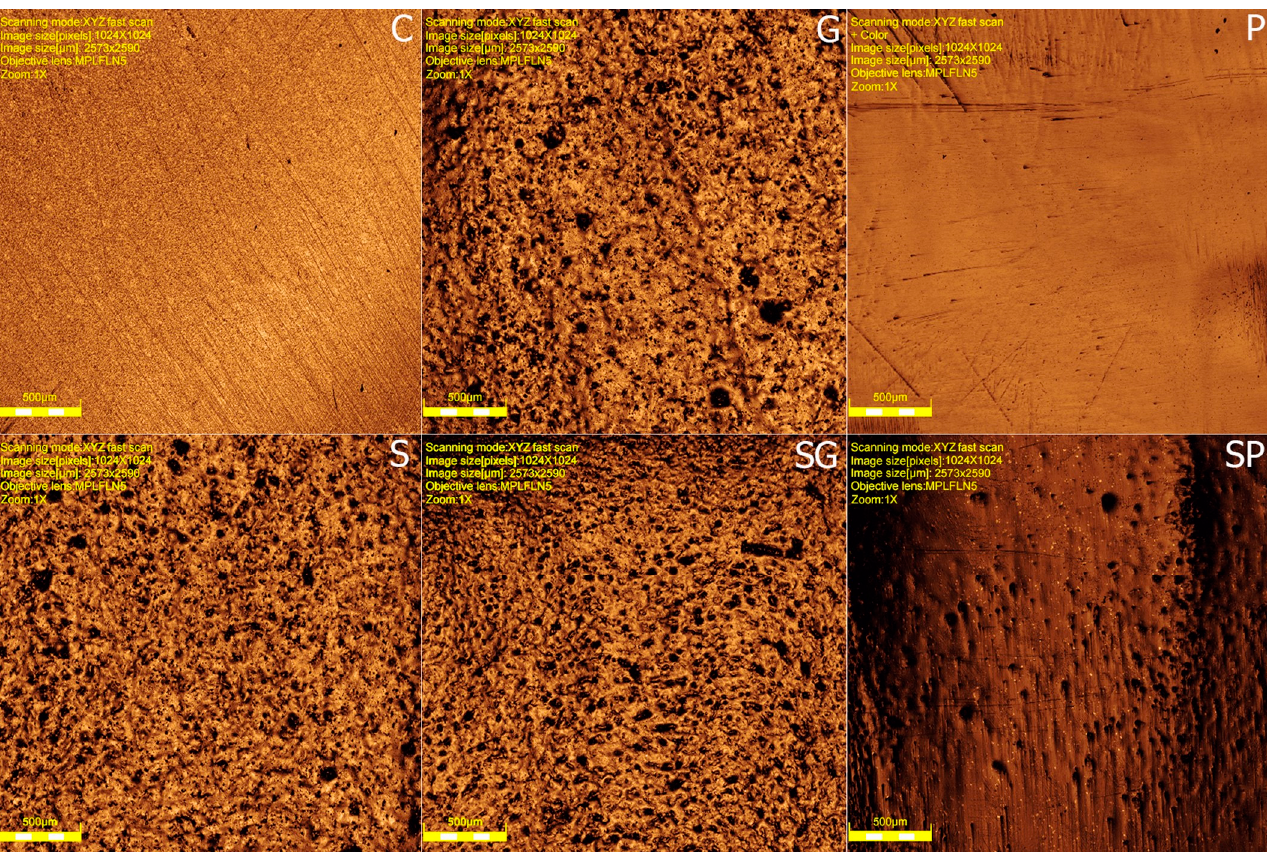
Figure 4. Laser confocal microscopy images showing the different surface morphology for all groups, including C (control), G (glazing), P (polishing), S (staining), SG (staining plus glazing), and SP (staining plus polishing). Table 2. The vertical height loss (VHL) of hemispheres ( µ m) opposing stabilized zirconia with 5 mol% of yttrium oxide (5Y-TZP), lithium disilicate, leucite-reinforced ceramic, and microhybrid composite resin for all